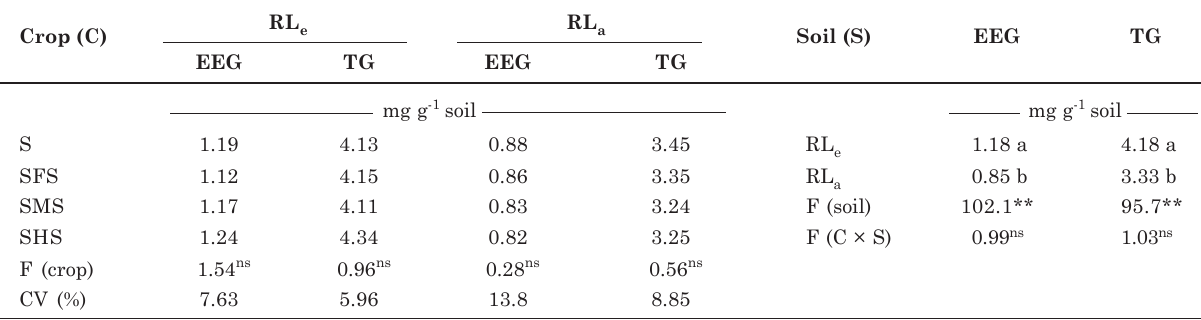
Table 1. Easily extractable glomalin (EEG) and total glomalin (TG) in the 0.00-0.10 m soils layer after the first sugarcane harvest